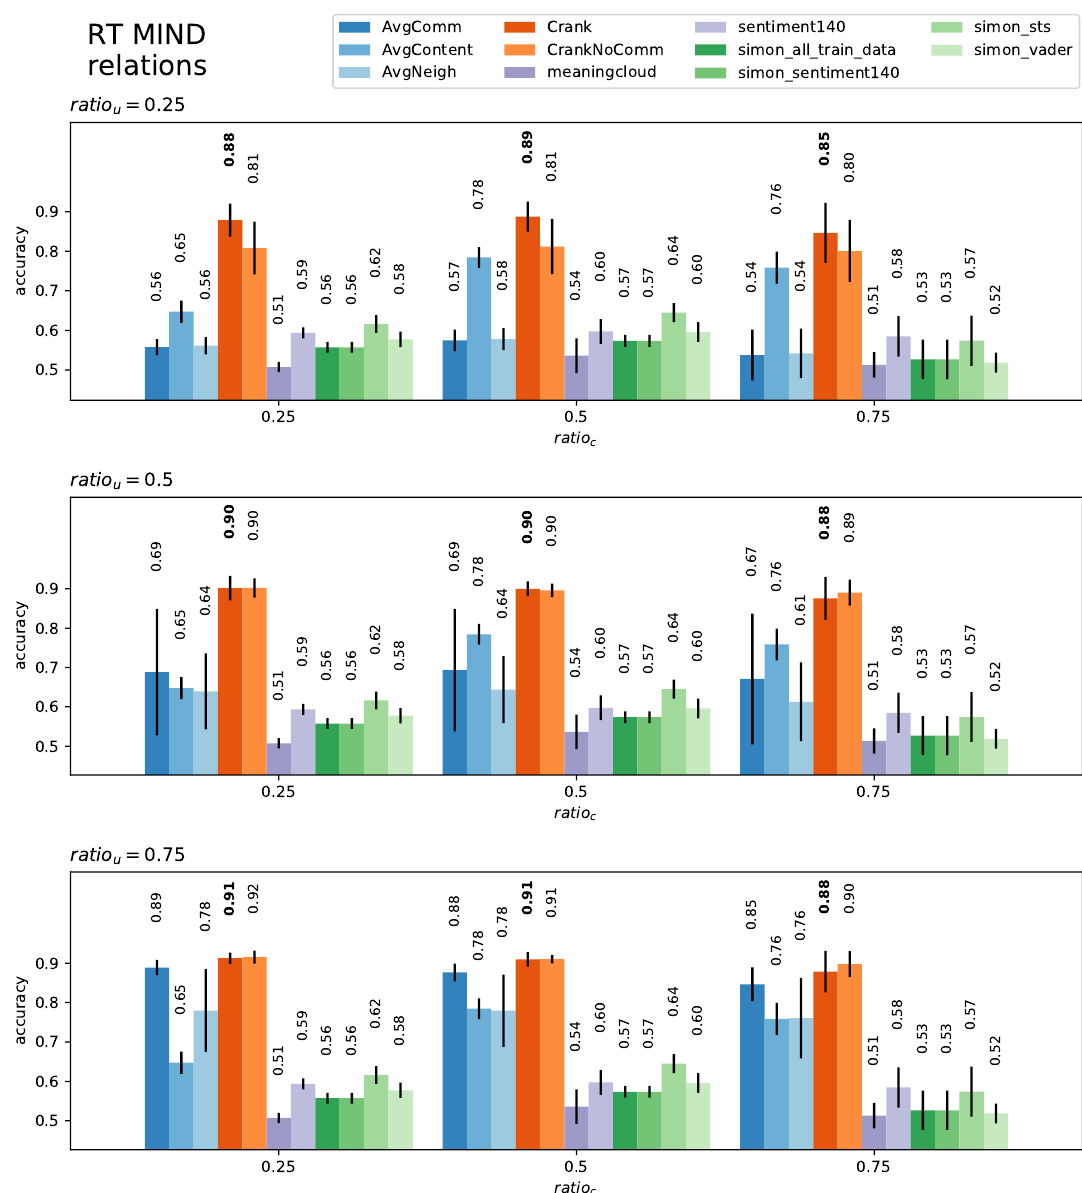
Figure 5. Content-level classification mean accuracy and standard deviation in the RT Mind dataset for each model at each level of certainty ( ratio u and ratio c )